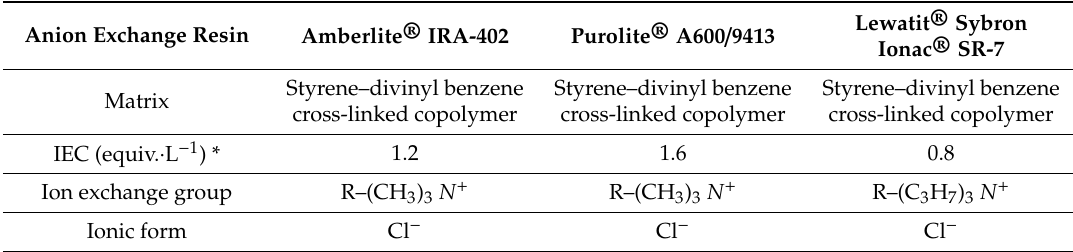
Table 1. Properties of the anion exchange resins used in this